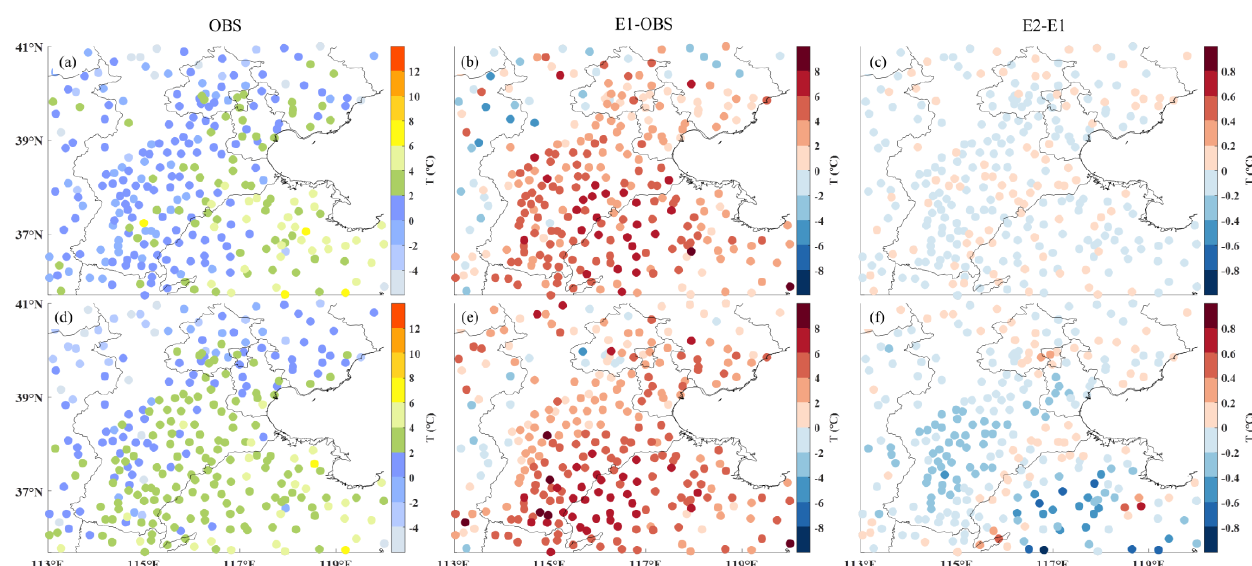
Figure 7. The spatial distribution of mean 2m temperature in the daytime. (a, d) The mean observations. (b, e) The bias of the E1 experiment. (c, f) The difference between the E2 and E1 experiment. The top and bottom row are data on 5 and 7 January 2017, respectively.